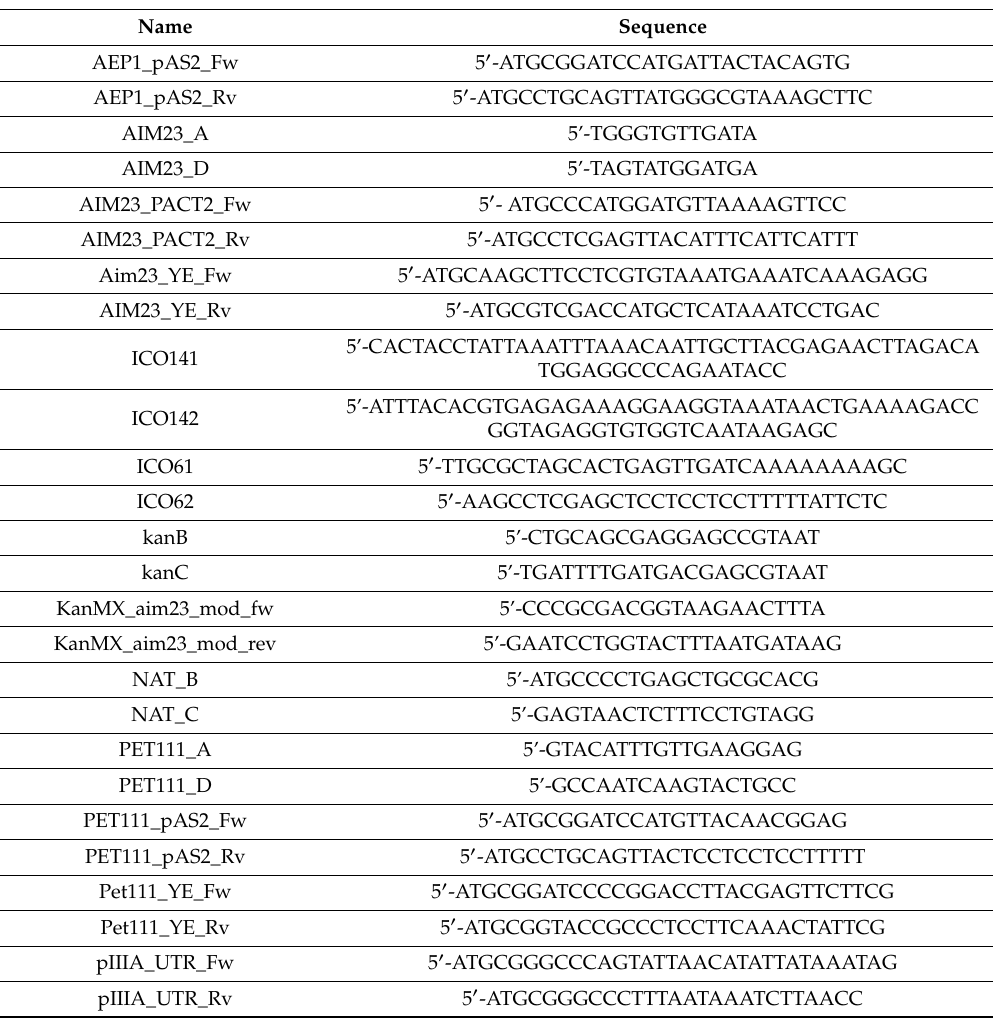
Table 3. Oligonucleotides used in the work. All synthesized by Evrogen